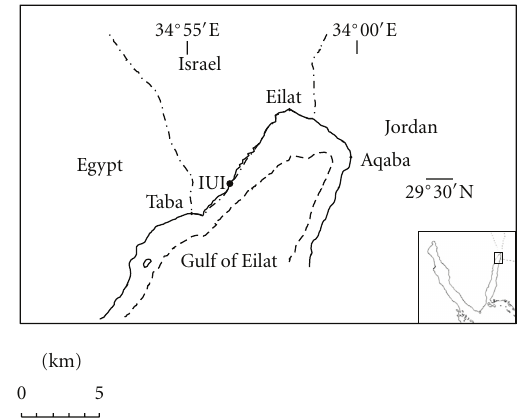
Figure 1: Study site map. Map showing study site along the coast of Eilat, the northern tip of the Gulf of Aqaba (Eilat), Red Sea:, Inter- University Marine Institute